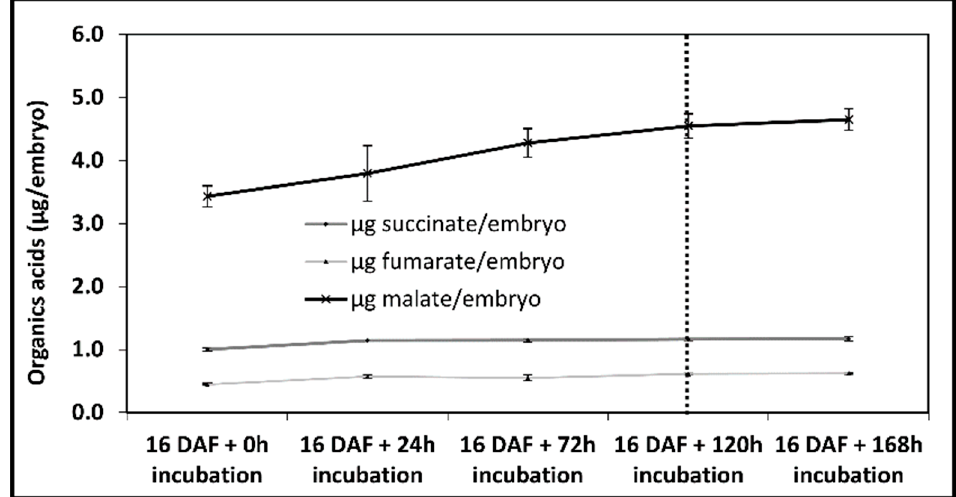
Figure 3. Concentration of organic acids (µg/embryo) during in vitro incubation. Organic acid concentrations were determined as described in the “Materials and Methods” section from flax embryos cultivated from 16 DAF for 24, 72, 120 and 168 h in culture medium A, containing unlabeled glucose and glutamine as the carbon source. For each kinetic point, four independent experiments were carried out.